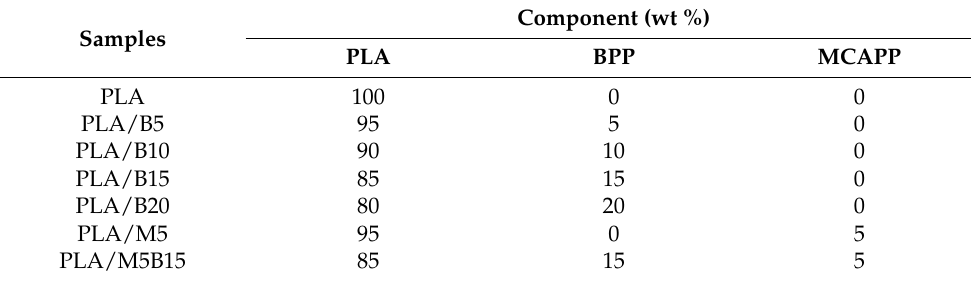
Table 1. The formulations of poly(lactic acid) (PLA) and PLA composites. Component (wt %) Samples PLA BPP MCAPP PLA 100 0 0 PLA/B5 95 5 0 PLA/B10 90 10 0 PLA/B15 85 15 0 PLA/B20 80 20 0 PLA/M5 95 0 5 PLA/M5B15 85 15 5